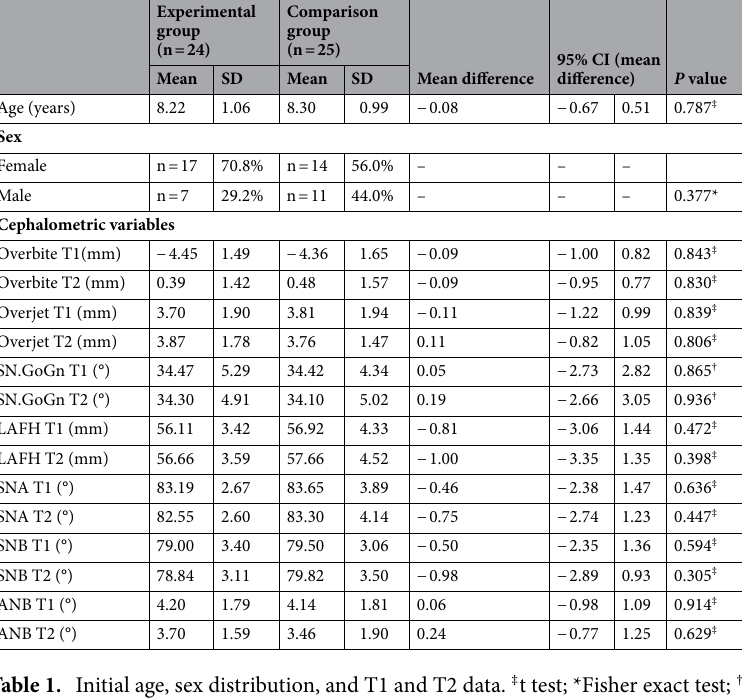
Table 1. Initial age, sex distribution, and T1 and T2 data. ‡ t test; *Fisher exact test; † Mann Whitney U test; SD, Standard deviation; SN.GoGn, mandibular plane angle; LAFH, lower anterior face height; SNA, sella-nasion- Apoint angle; SNB, sella-nasion-Bpoint angle; ANB, Apoint-Nasion-Bpoint angle.